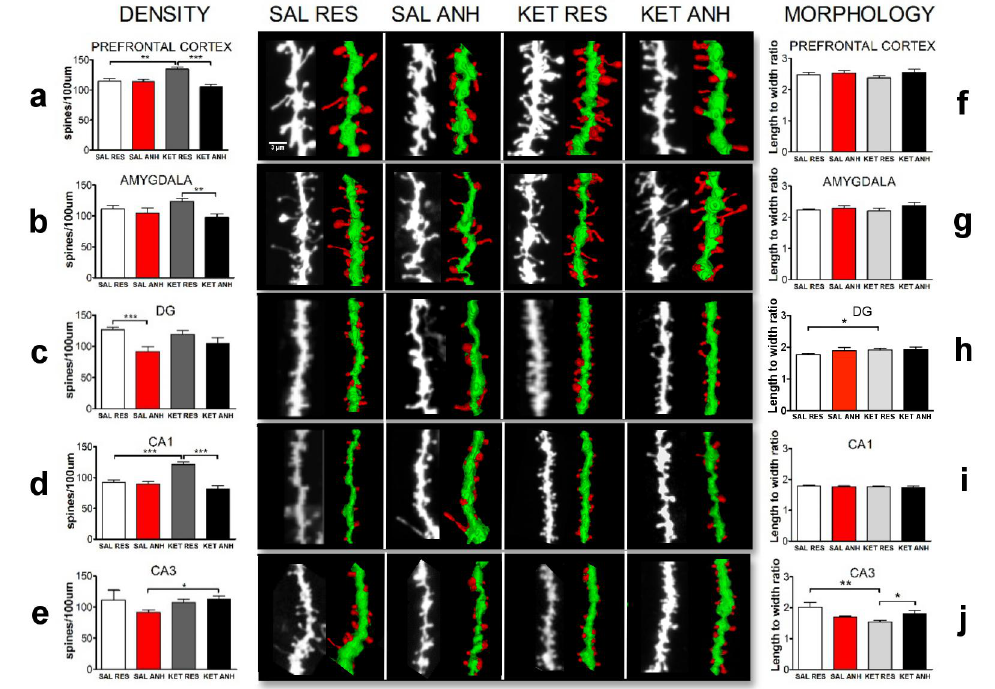
Figure 2. Ketamine treatment before the CUS procedure affected the density and morphology of dendritic spines on day 8 of the recovery period. The figure shows the density ( a – e ) and morphology ( f – j ) of dendritic spines in prefrontal cortex, amygdala, DG, CA1 and CA3 subregions of hippocampus of mice that were injected before CUS procedure with saline (SAL) or ketamine (KET) and followed CUS protocol leading to manifestation of anhedonic (ANH) or resilient (RES) behavior. The data are expressed as mean ± SEM. * p < 0.05, ** p < 0.01, *** p < 0.001. n ≥ 3 animals/group. Besides bar